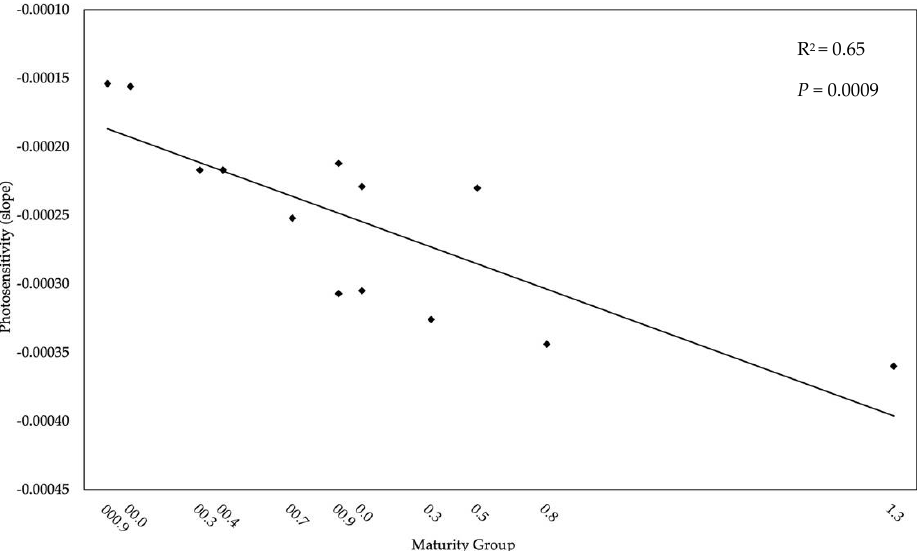
Figure 3. Relationship between increasingly later soybean maturity group (MG) and sensitivity to photoperiod and its corresponding coefficient of determination (R 2 ) and p -value.